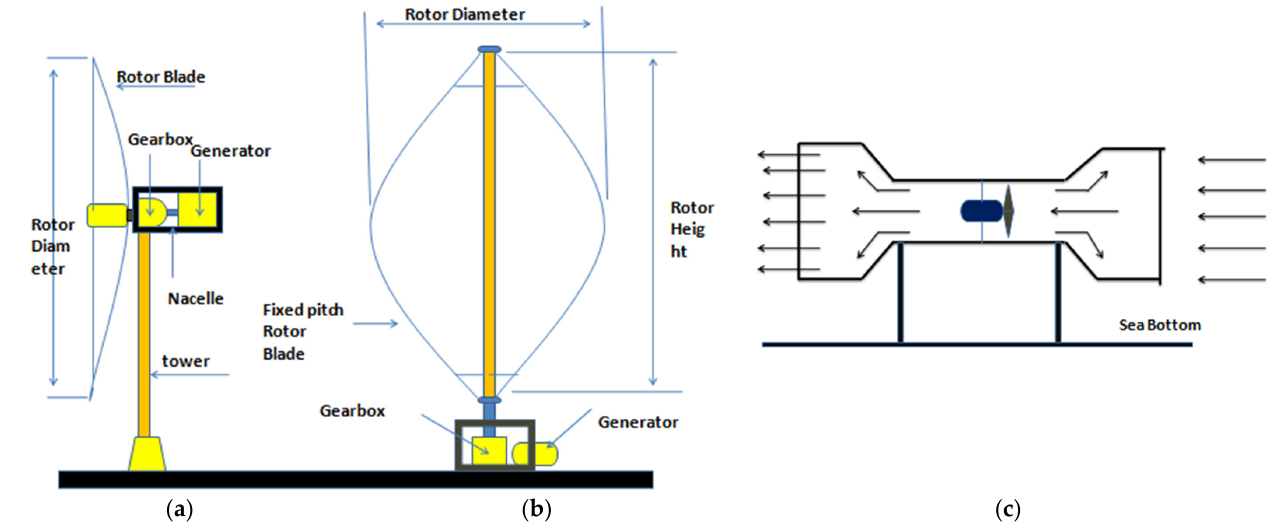
Figure 12. Working principles of different tidal current technologies: ( a ) HATCT, ( b ) VATCT, and ( c ) enclosed turbines.